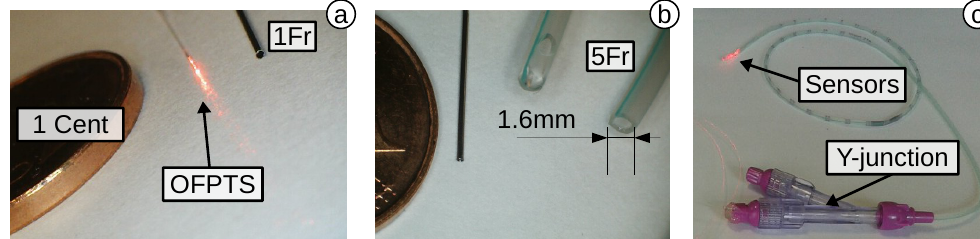
Figure 18. Compared to a cent: ( a ) OFPTS (red illuminated) and 1-Fr tube; ( b ) 5-Fr NutriSafe catheter; ( c ) two sensors in a single 5-Fr